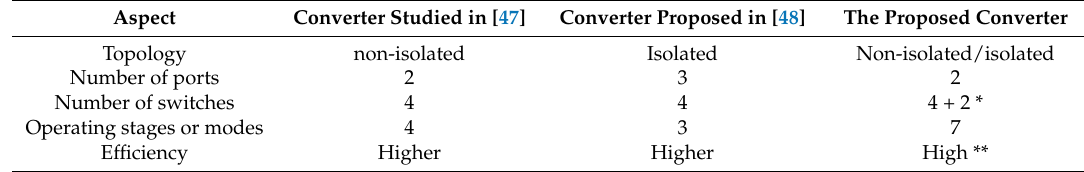
Table 3. Comparison of the proposed converter with other bidirectional converters.